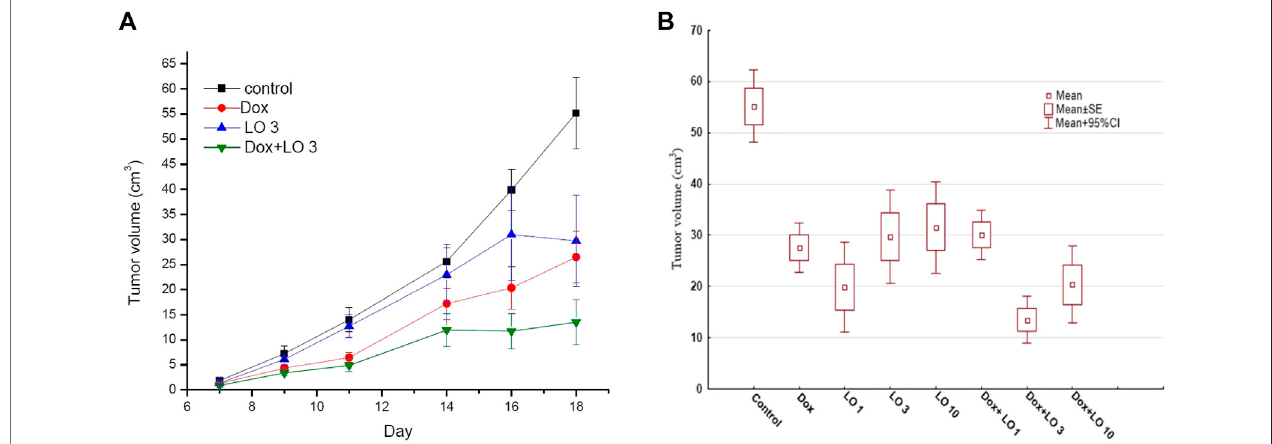
FIGURE1| ThedynamicschangesofPLStumorvolumeoverthewholecourseoftreatment (A) ;thetumorvolume11 daysafterthestartoftreatment (B) .Thedata obtained three independent experiments for Control, Dox, LO 3, and Dox+LO 3 groups. The values represent the mean ± 95% CI (A,B) .